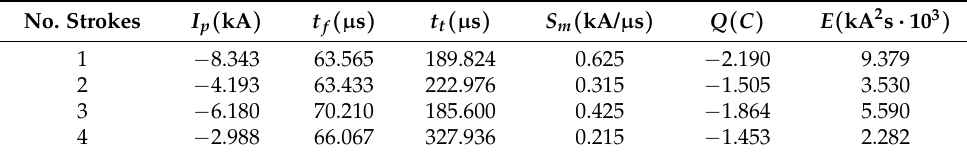
Figure 6. Statistical distribution of multicomponent negative lightning flashes. Table 4. Parameters for multicomponent negative flash from Figure 7.